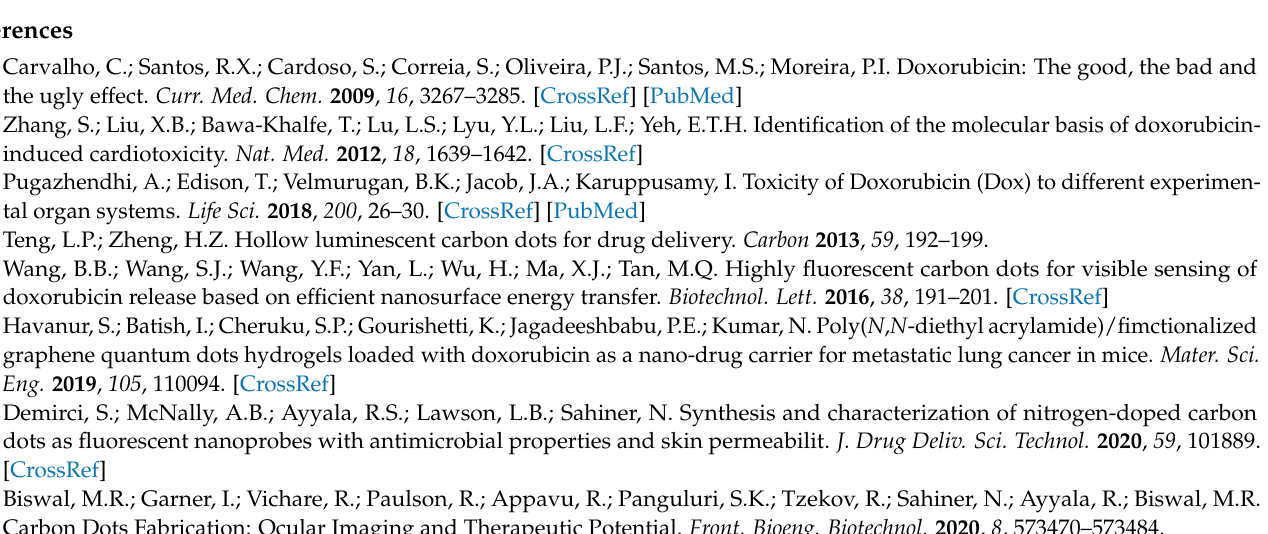
water, Figure S4: The information of the FCS measurements of CDs in U2OS Cells, Figure S5: Transmembrane process of FCS measurements of DOX, Figure S6: Free diffusion stage of CDs, DOX and CDs-DOX in U2OS, Figure S7: Transmembrane process of FCS measurements of CDs-DOX, Figure S8: Transmembrane process of FCS measurements of CDs-DOX, Figure S9: Transmembrane process of FCS measurements of CDs, Figure S10: Transmembrane process of FCS measurements of DOX, Figure S11: Confocal images of CDs, DOX and CDs-DOX in U2OS cells from 5 to 60 min, Figure S12: Confocal images of CDs, DOX and CDs-DOX in COS7 cells from 5 to 60 min, Figure S13: Transmembrane transport of CDs, DOX and CDs-DOX, Figure S14: The diffusion time of CDs, DOX, CDs-DOX, Figure S15: Transmembrane transport of CDs, DOX and CDs-DOX under different pH